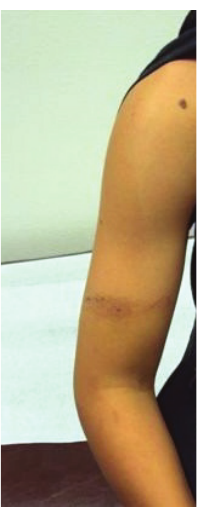
Figure 2: Contusion mark on the right arm due to tight twisting of rope during the tug-of-war